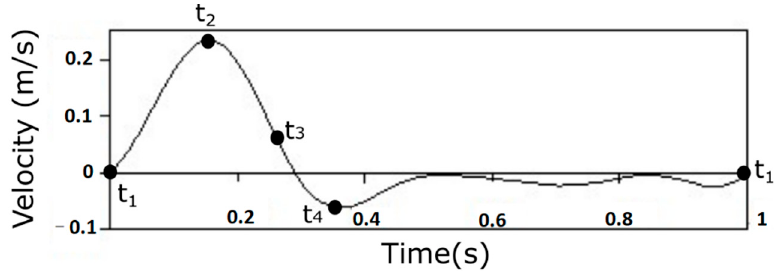
Figure 1. Axial velocity on the inlet with the representation of different time instants: t 1 = 0.00 s, t 2 = 0.16 s, t 3 = 0.26 and t 4 = 0.36 s.